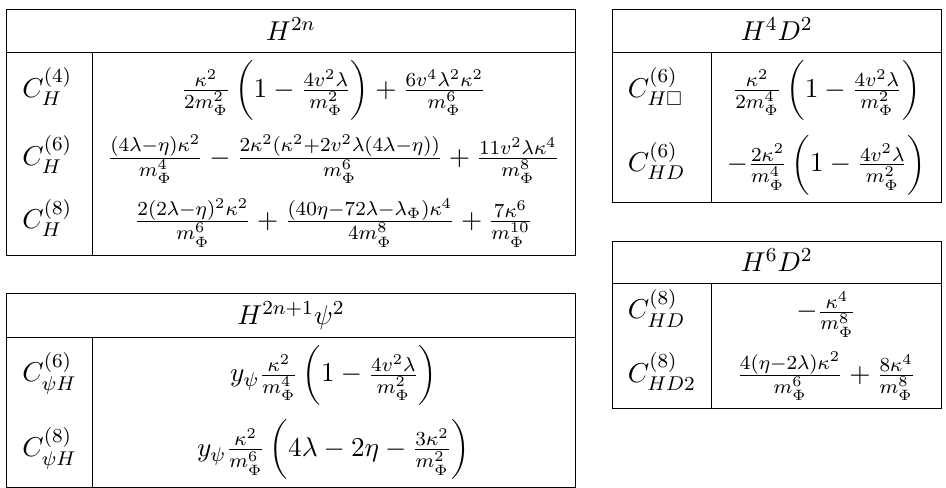
Table 10 . Matching for the electroweak triplet scalar up to L (8) . These matching results are consistent with geoSMEFT conventions on operator forms and are sufficient to examine observables constructed via two and three point